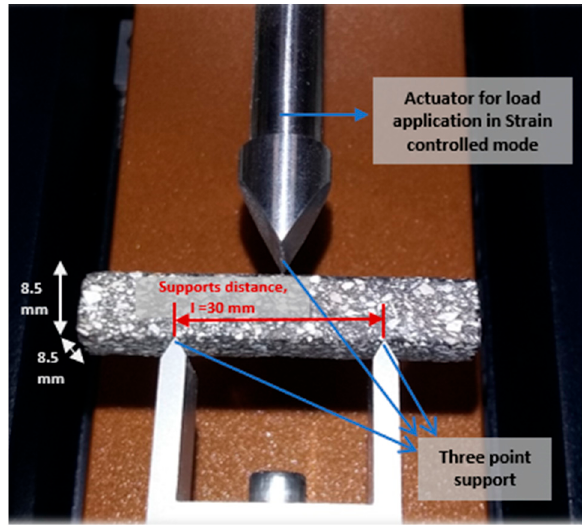
Figure 3. Layout of the three-point bending configuration employed in mortar characterization.